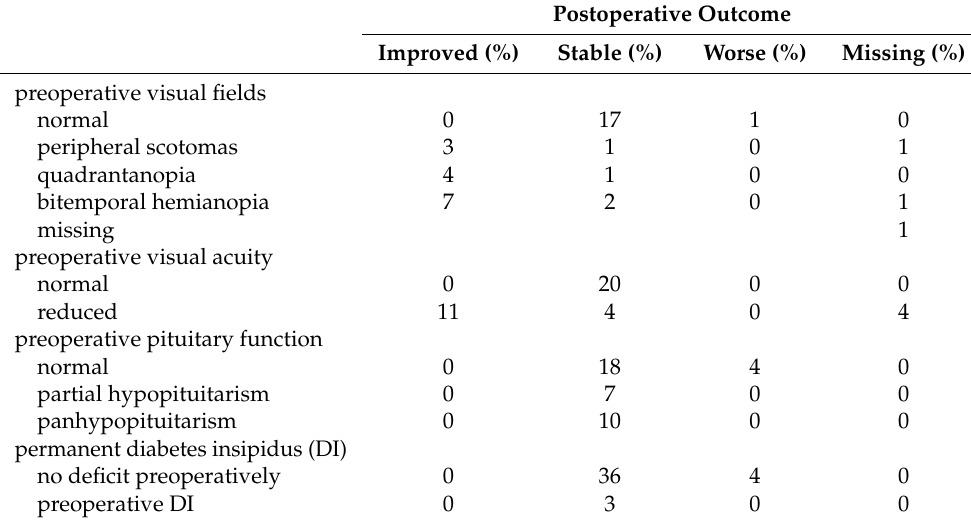
Table 2. Postoperative outcome.